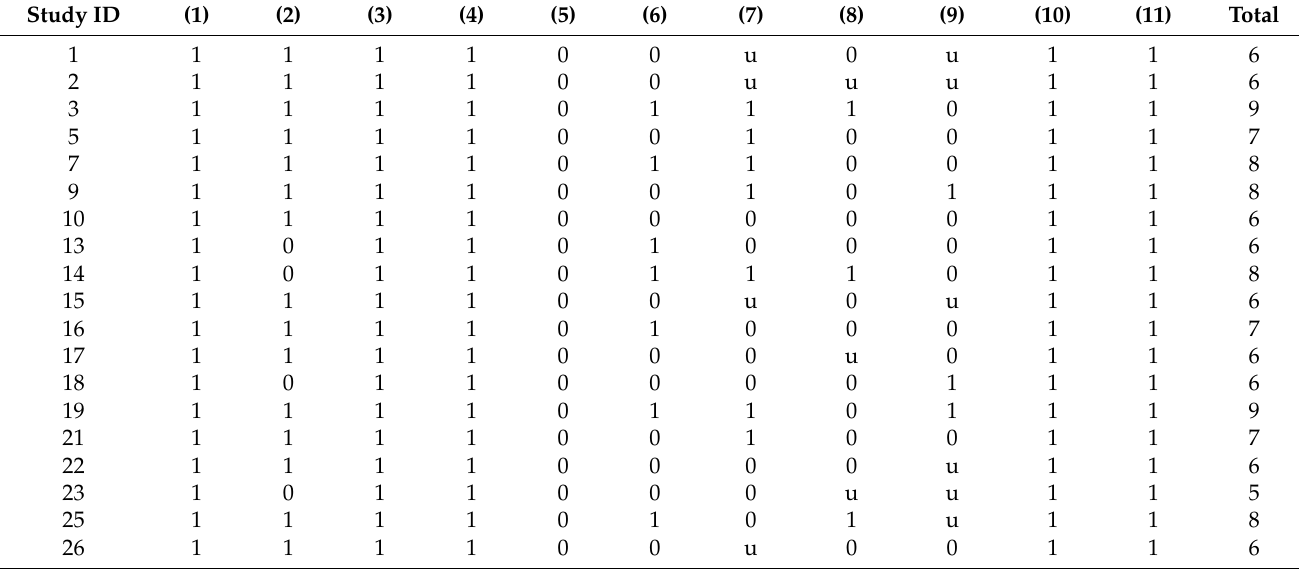
Table A1. Cross-sectional study quality